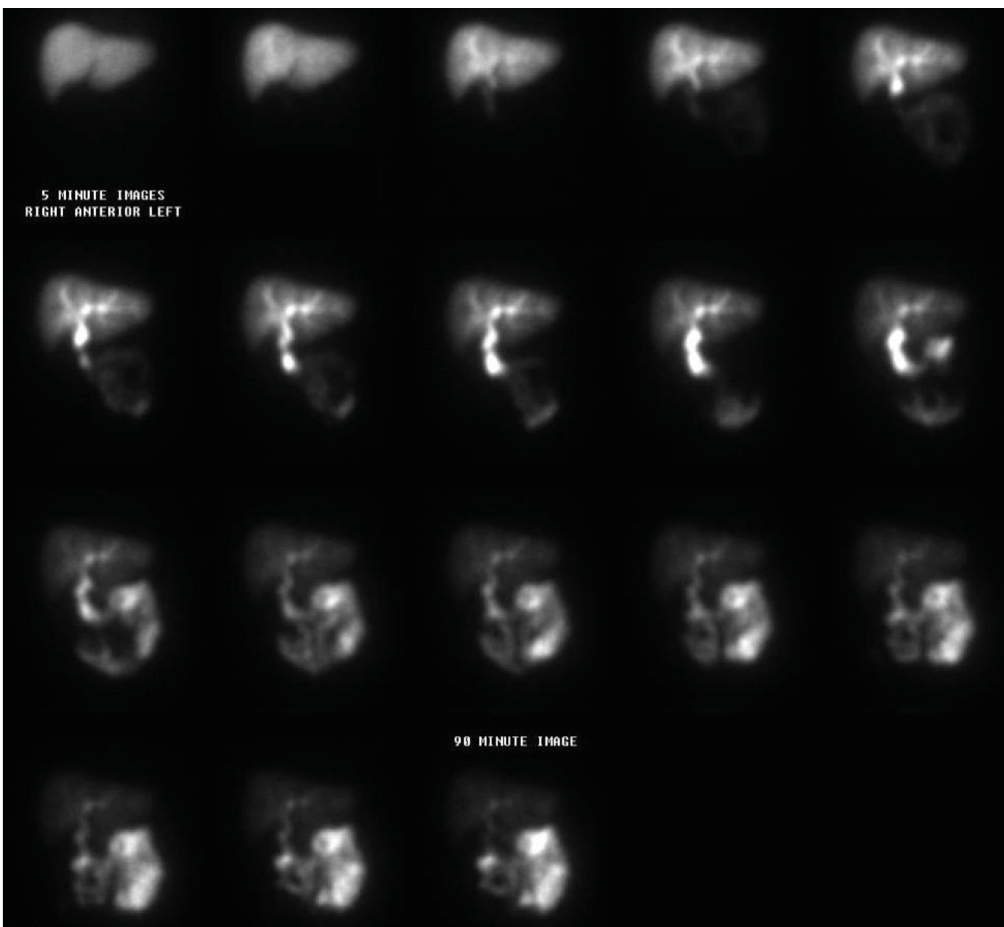
Figure 5: 35-Year-old female with biliary colic concerning for acute cholecystitis. Findings: HIDA scan demonstrating nonvisualization of the